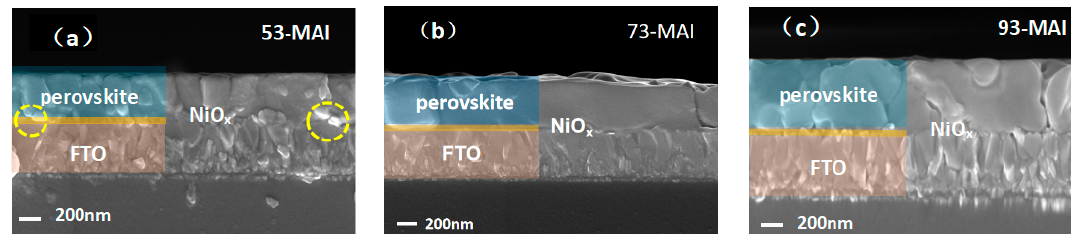
Figure 5. SEM cross-sectional views of organic–inorganic hybrid perovskite films with different concentrations of MAI precursor solution. ( a – c ) show the films with MAI concentrations of 53 mg/mL, 73 mg/mL, and 93 mg/mL, respectively.